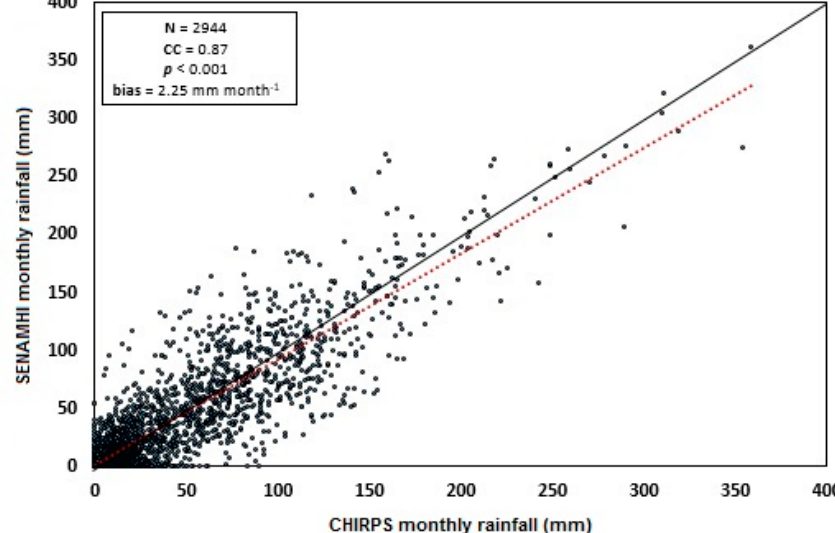
Figure 2. Scatter plot of monthly rainfall estimates from Climate Hazards Group InfraRed Precipitation with Station Data (CHIRPS) versus in-situ measurements from Servicio Nacional de Meteorología e Hidrología (SENAMHI) stations.